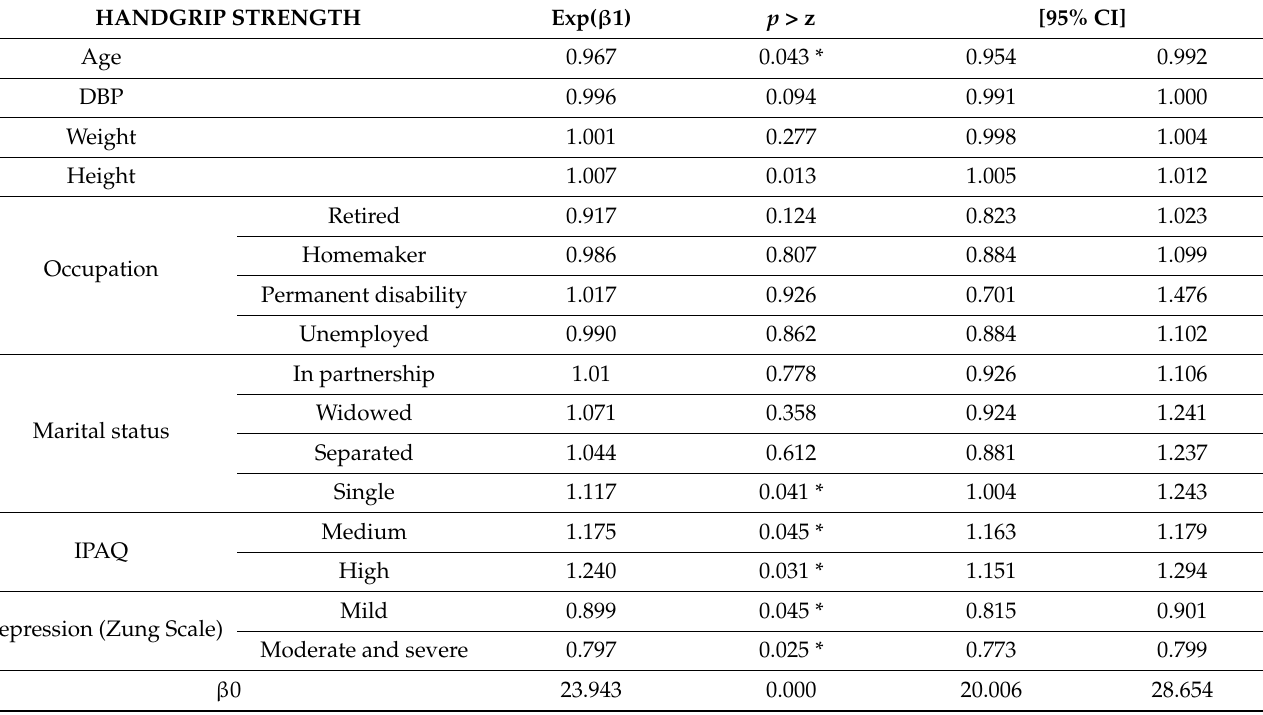
Table 4. Association between handgrip strength and the clinical and sociodemographic characteristics of participants (multiple